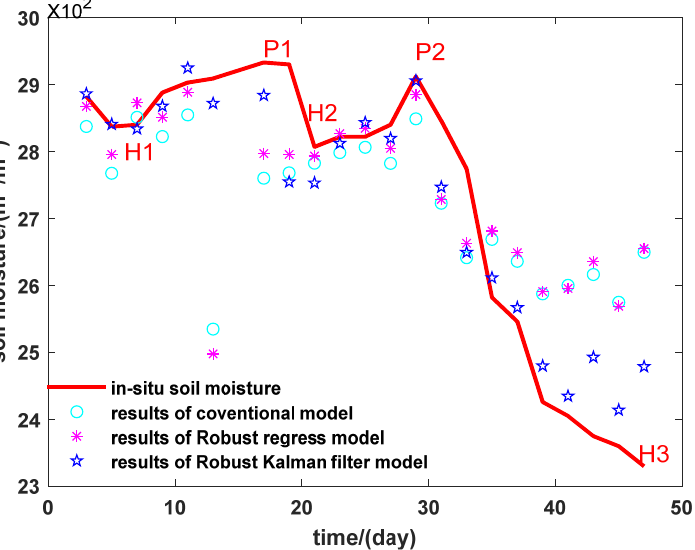
Figure 9. Estimation results of dual-band data fusion methods by using phase, we highlighted for validation data the main moisture peaks (P1 day 17; P2 day 29) and holes (H1 day 6; H2 day 20; and H3 day 47). We can note that the difference between H1 and P1 is less than 1*10 -2 m 3 /m 3 and between H2 and P2 it is ~1*10 -2 m 3 /m 3 which is low and will allow us to test the precision of the inversions and to show the capacity of this technique to differentiate between very weak soil moisture fluctuations.